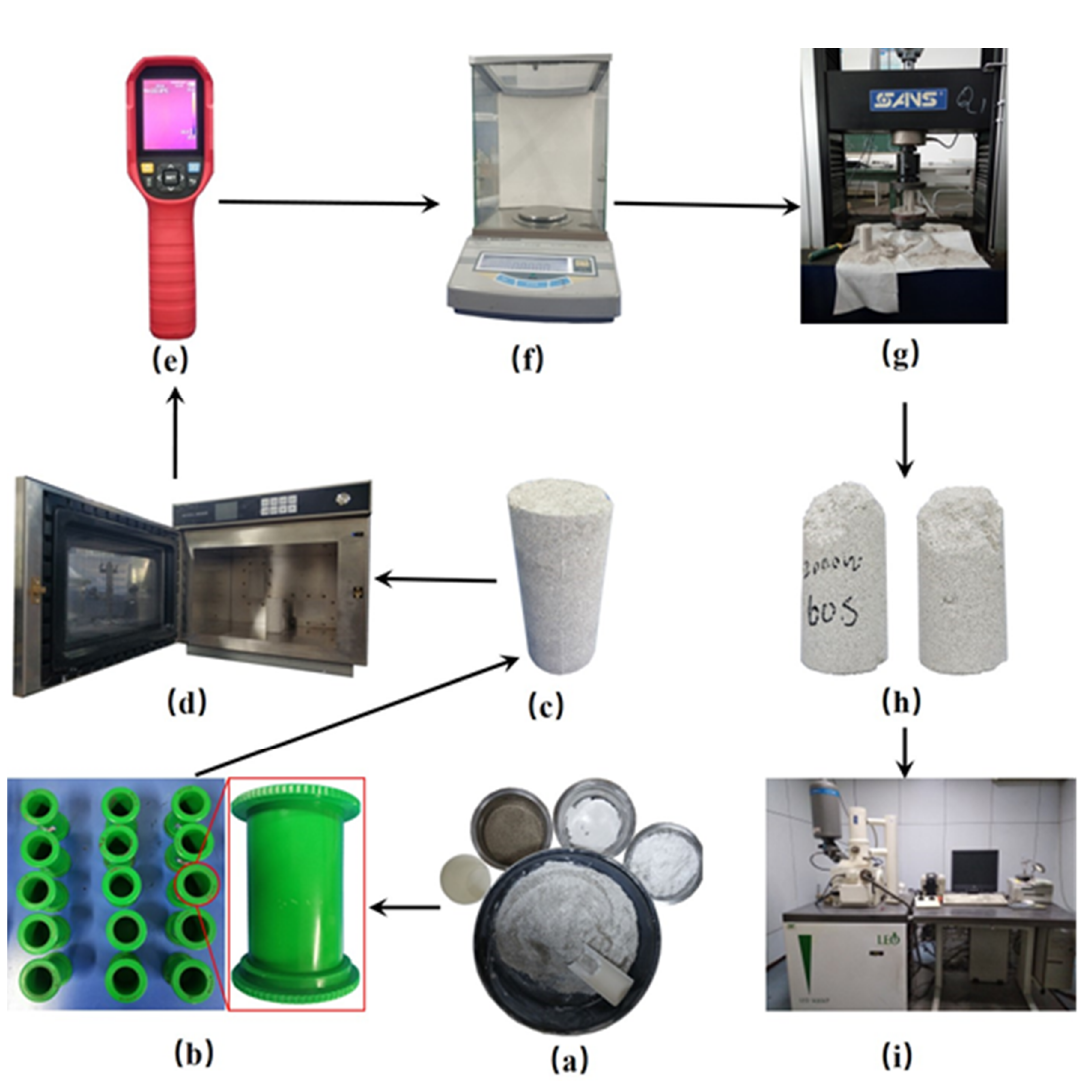
Figure 1. Instrumentation used in the research experiments. ( a ) Water, sand, gypsum, heavy stone powder, and mixing tools used to make standard specimens. ( b ) Molds used for making ( c ) standard samples. ( d ) Industrial microwave oven. ( e ) Handheld infrared thermal imager. ( f ) High-precision electronic balance. ( g ) Uniaxial Compressor. ( h ) Destroyed specimen. ( i ) SEM.